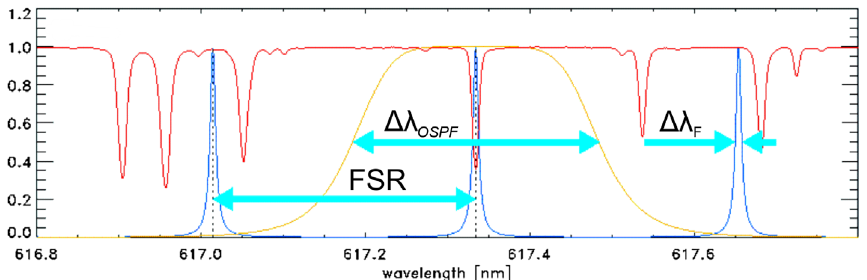
Fig. 2. Spectral fi lters used by PMI. Plotted are the solar spectrum around 617 nm (red; Fourier Transform Spectrometer (FTS) atlas; see Neckel & Labs, 1984), tunable fi lter pro fi le (blue) and bandpass of the order-sorting pre fi lter (OSPF) (yellow). FSR denotes the free spectral range of the tunable fi lter; D k F and D k OSPF denote the full width at half maximum of the tunable fi lter and the OSPF, respectively.